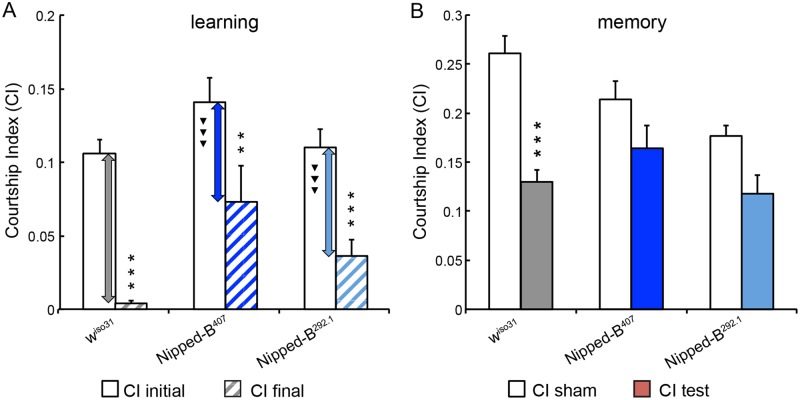

Nipped-B heterozygotes are deficient in learning and short-term memory.(A) Similar to w
iso31 controls (p<0.0001) heterozygous Nipped-B males of both alleles (Nipped-B
407 (p = 0.007) and Nipped-B
292.1 (p<0.0001)) show significant decrease in their courtship activities through training sessions with non-receptive pre-mated females, suggesting that these flies display learning in experience-based conditioning. However, when the amount of decline between CI initial and CI final is compared between each Nipped-B heterozygote and the w
iso31 controls, the decrements in the mutants are significantly smaller. (B) When tested for their courtship behaviors towards receptive virgin females after a short break (1 hour), trained w
iso31 controls show a near 50% reduction in their courtship behaviors (CI test) compared the naïve w
iso31 males (CI sham) (p<0.0001). However, heterozygotes of neither Nipped-B mutant show a significant difference to their naïve peers, for Nipped-B
407, p = 0.10 and for Nipped-B
292.1, p = 0.059. Over 18 flies were tested for each genotype in a given assay. Student’s t-tests were used for analyses with the levels of significance marked by number of *: *, p<0.05; **, p<0.01; ***, p<0.001. One-way ANOVA post hoc Tukey tests were used to decide statistical difference in learning capacity between Nipped-B
407 or Nipped-B
292.1 heterozygous males with w
iso31 controls; ▼, p<0.05; ▼▼, p<0.01; ▼▼▼, p<0.001.